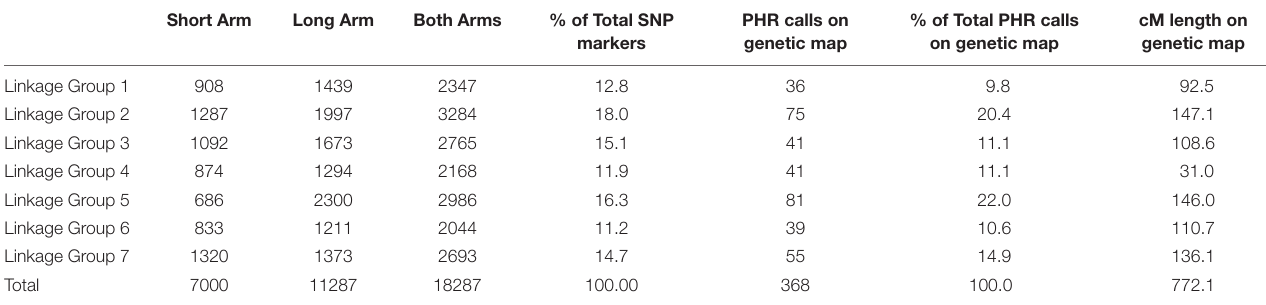
TABLE 2 | Number of SNP markers polymorphic between wheat and T. urartu on the Affymetrix Axiom R (cid:13) Wheat-Relative Genotyping Array for each linkage group of the A u genome and final number of SNP markers mapped onto the genetic map of the A u genome of T. urartu obtained through Poly High Resolution (PHR) calling. Short Arm Long Arm Both Arms % of Total SNP